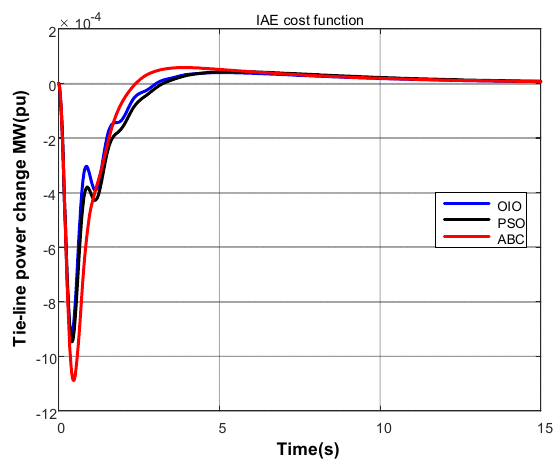
Figure 11. Change in tie ‐ line power for ITAE.